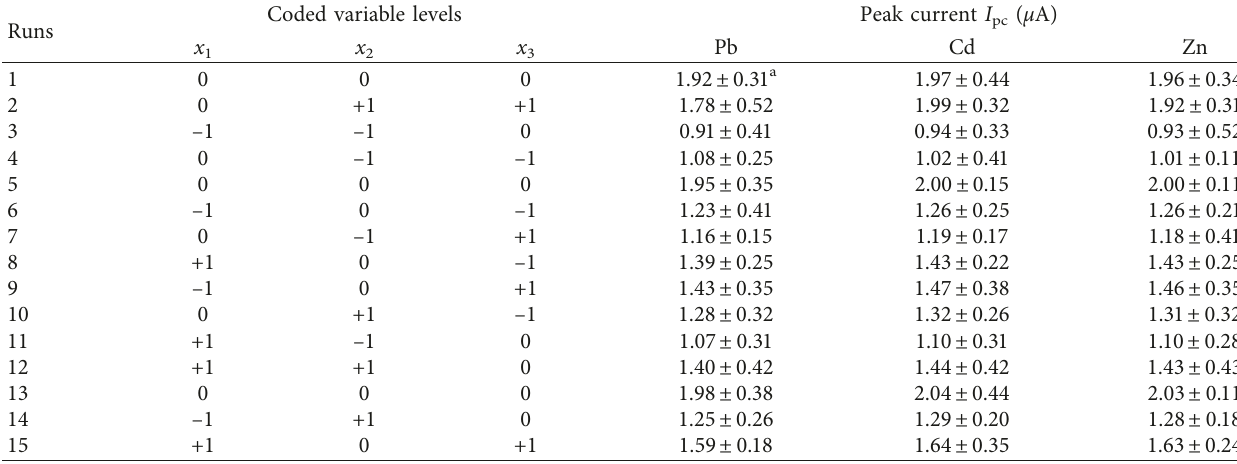
Table 2: Design matrix and responses for full factorial